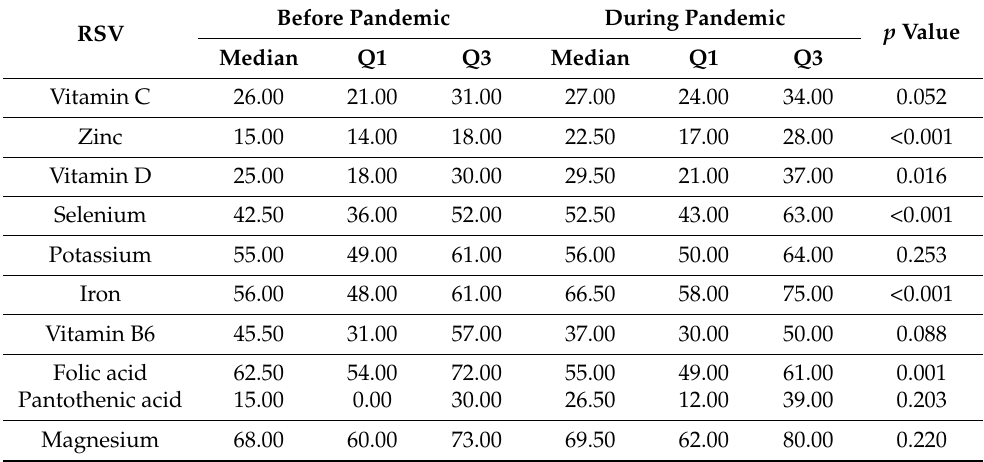
Table A2. Comparison of the RSV of individual ingredients from the period before the pandemic was announced and from the period after its announcement using the U Manna-Whitney test (with continuity